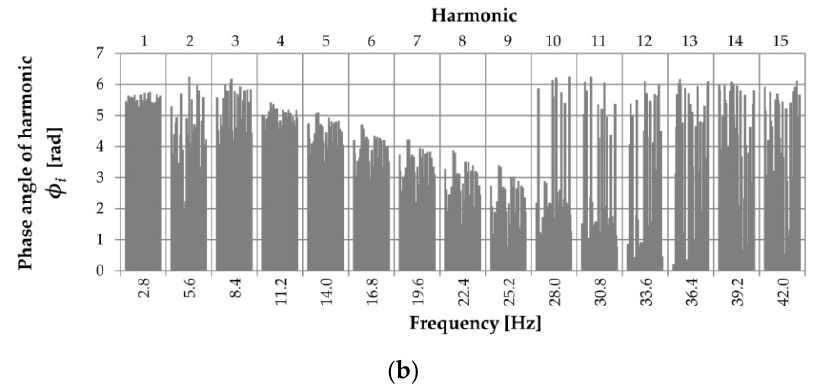
Figure 7. The charts of ( a ) normalised amplitudes (log scale for the φ i -axis) and ( b ) phase angles (linear scale for both axis) of the fifteen harmonics determined for forty F VGRF samples generated by four heel-strike runners ( f r = 2.80 Hz) (The data presented can be found in Supplementary Materials in the form of text files containing numerical data. See section Supplementary Materials).